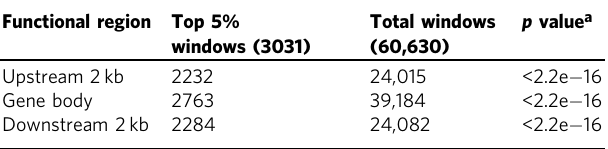
Table 1 Enrichment of the (G/C) 3 L 1 – 7 G4 motif clusters in the genic regions of the human